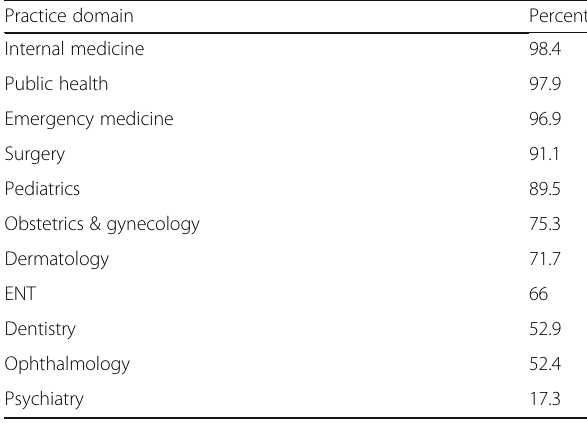
Table 3 Percentage of junior doctors performing one/more tasks in a domain on weekly basis, Ethiopia, 2015 ( N =